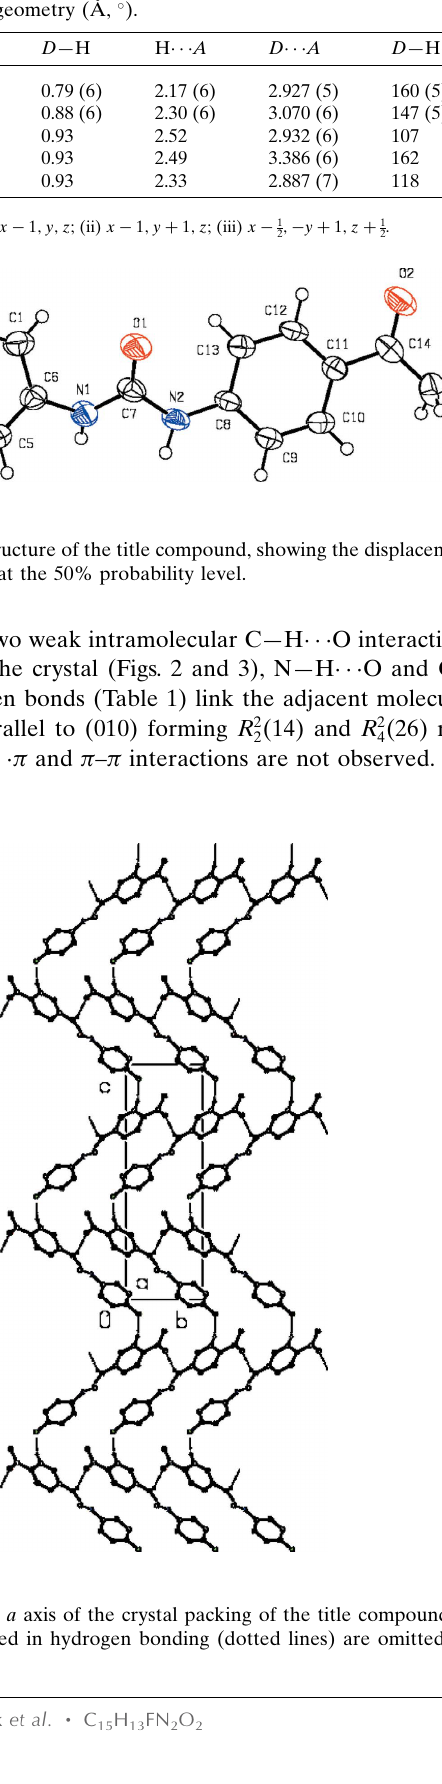
Figure 4 View of the three-dimensional Hirshfeld surface of the title compound mapped with d norm .